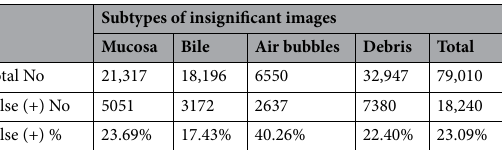
Table 5. False positive rate by the CNN model according to subtypes of insignificant